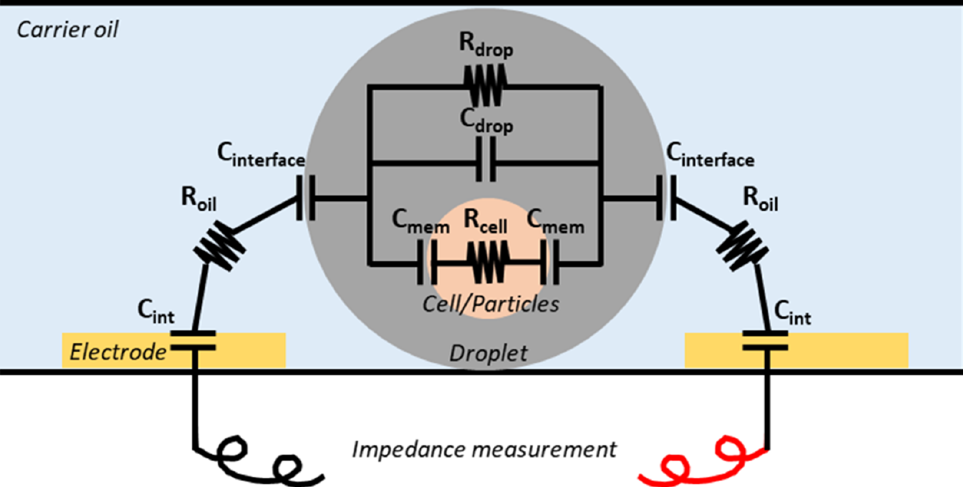
Figure 1. Impedance detection principle. The capacities between oil–water interface (C interface ), resistance (R drop ), and capacitance (C drop ) from droplet solution, as well as the capacitance from the cell membrane (C mem ) or particle interface, and resistance from cytoplasma (R cell ) or the particle solid content result in the detectable impedance changes that can help with the determination of droplet contents.